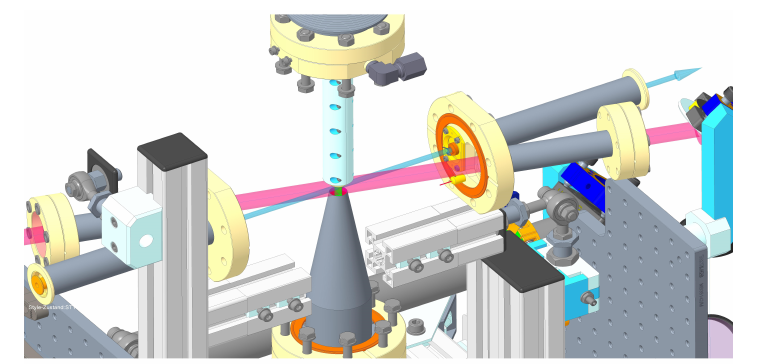
Figure 5. Technical drawing of the gas jet interferometry setup. the laser and beam are showing in the red and blue colour respectively. The laser is passing through the jet at 15 ◦ with respect to the beam axis inside a jet chamber that is not shown here for the clarity.